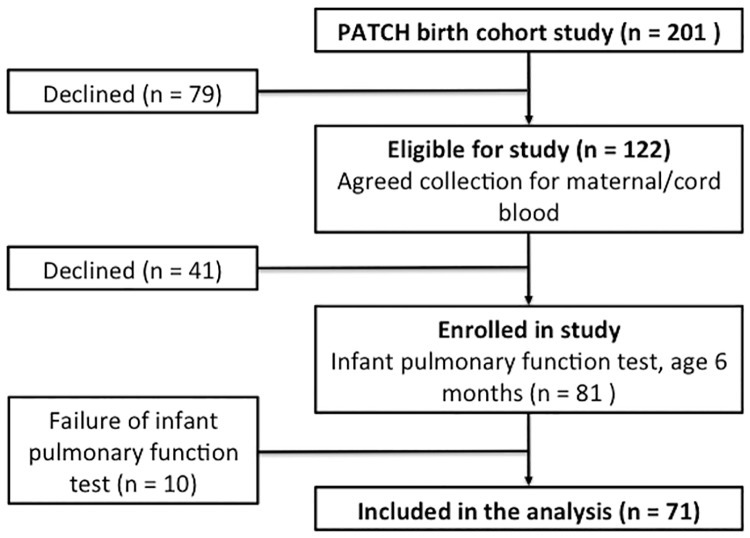
Study flow chart.